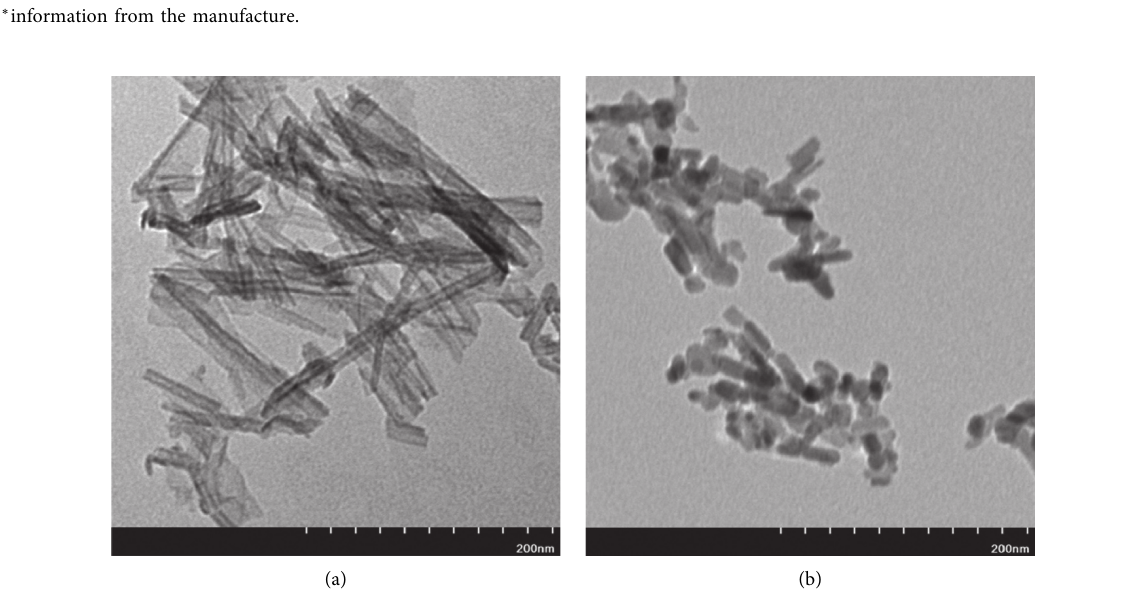
Figure 1: TEM images of (a) TNT-100 and (b) TNT-500.